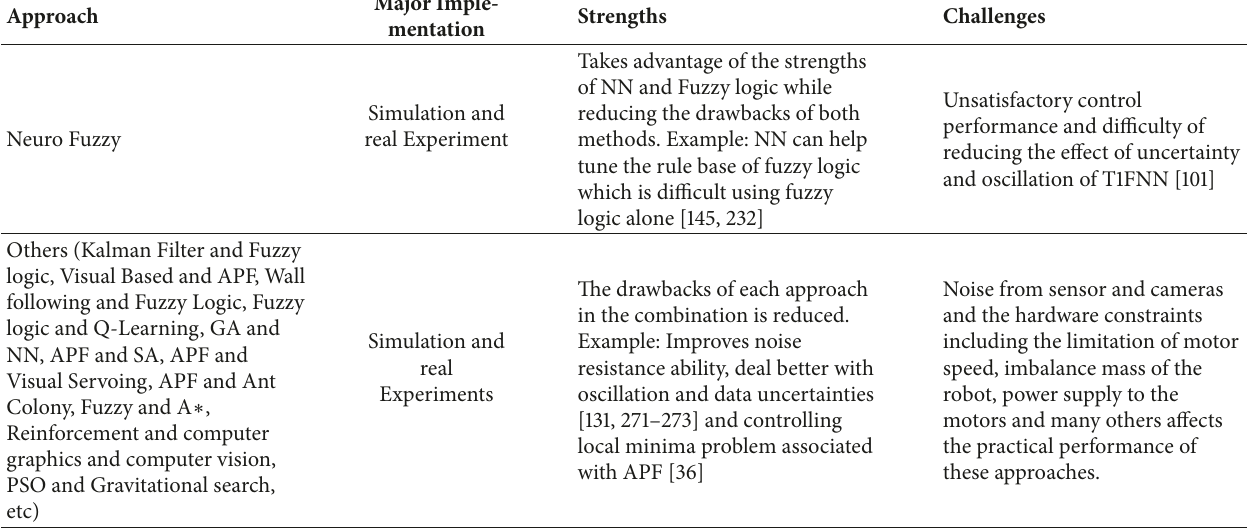
Table 3: Summary of strengths and challenges of hybrid mobile robot path planning and obstacle avoidance methods.